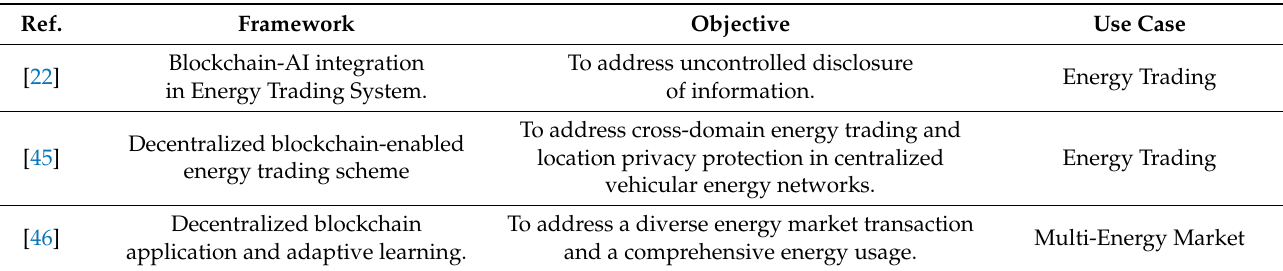
Table 16. Blockchain for AI based energy market